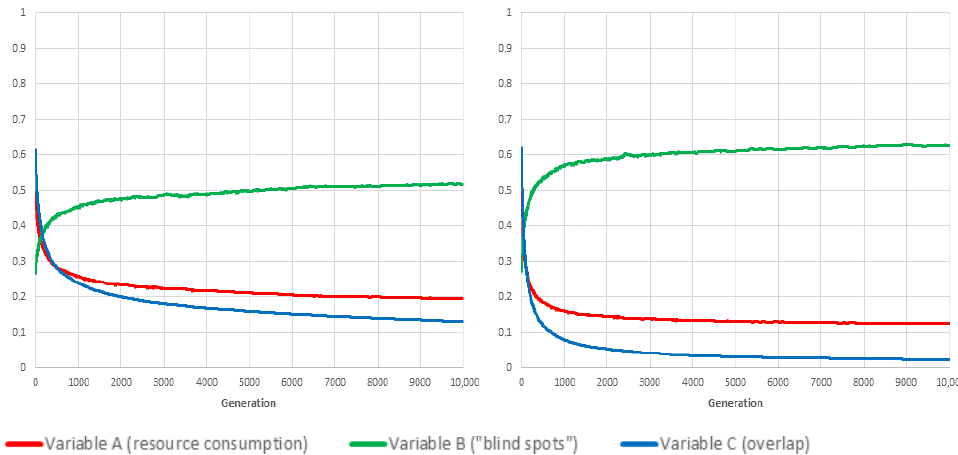
Figure 5. Benchmarking tests: setting γ = 1 implies (as above) that only one value contributes to F , namely, C , the overlap . In both variations of the GA C is being reduced but the GA with sexual reproduction ( right panel) significantly outperforms the variation that uses only mutation ( left